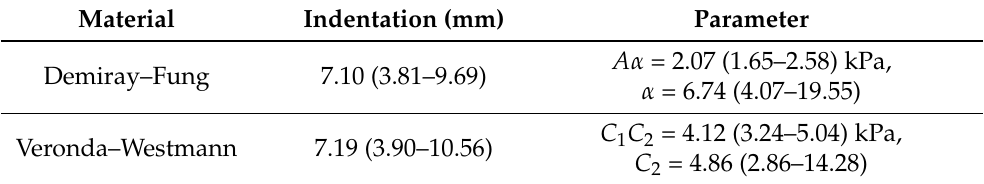
Table 5. Median (range) indentation and parameter estimates for DF and VW material models.